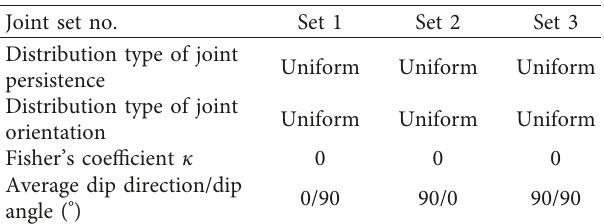
Figure 1: Disc model of the joint. n is the normal vector of the disc joint. Table 2: Distribution parameters of the joint parameters of the theoretical DFN